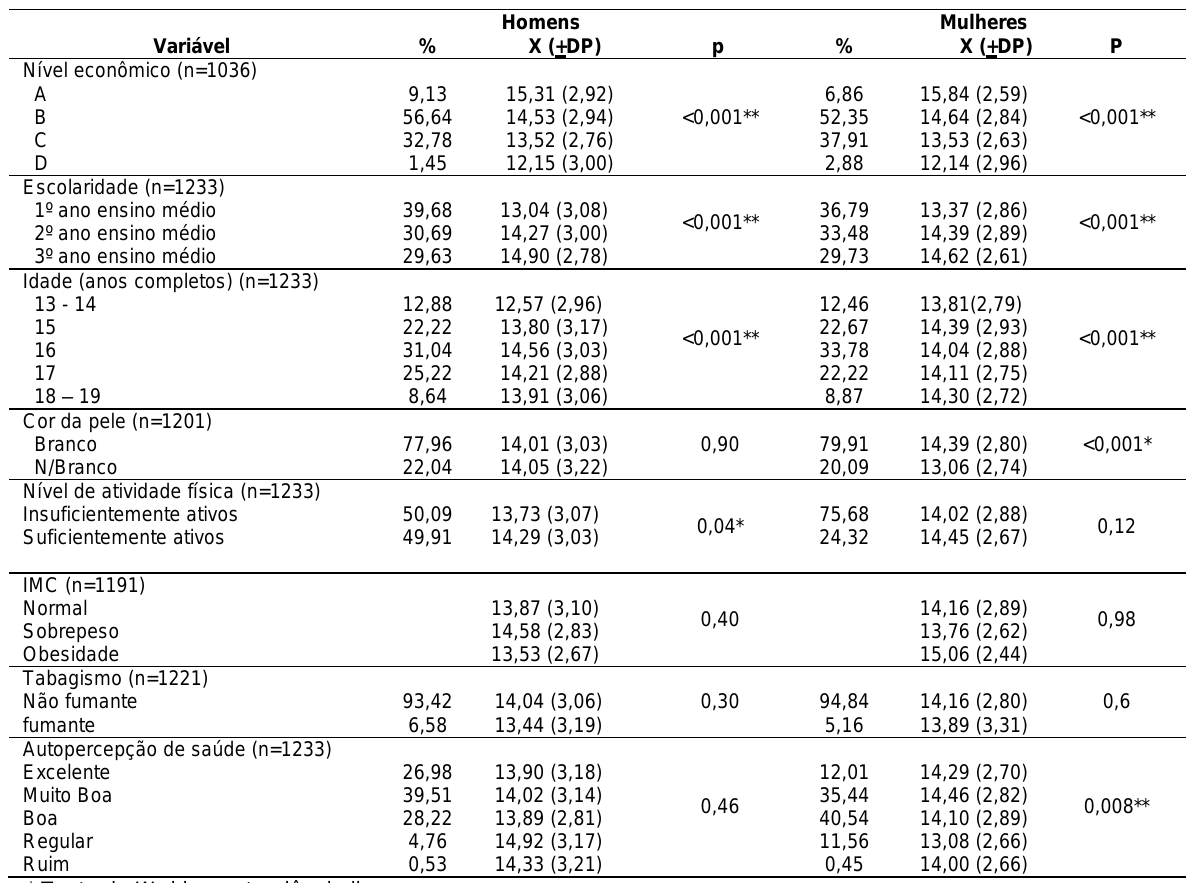
Tabela 4. Distribuição das variáveis demográficas, socioeconômicas, comportamentais, nutricional e